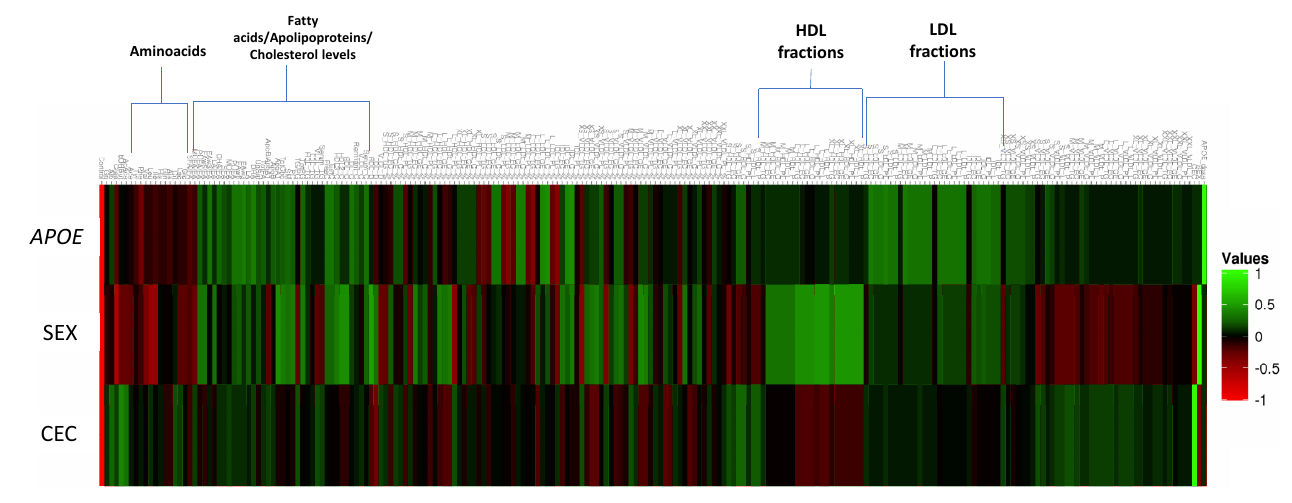
Figure 2: Global heatmap analyzing the patterns of correlations between plasma NMR